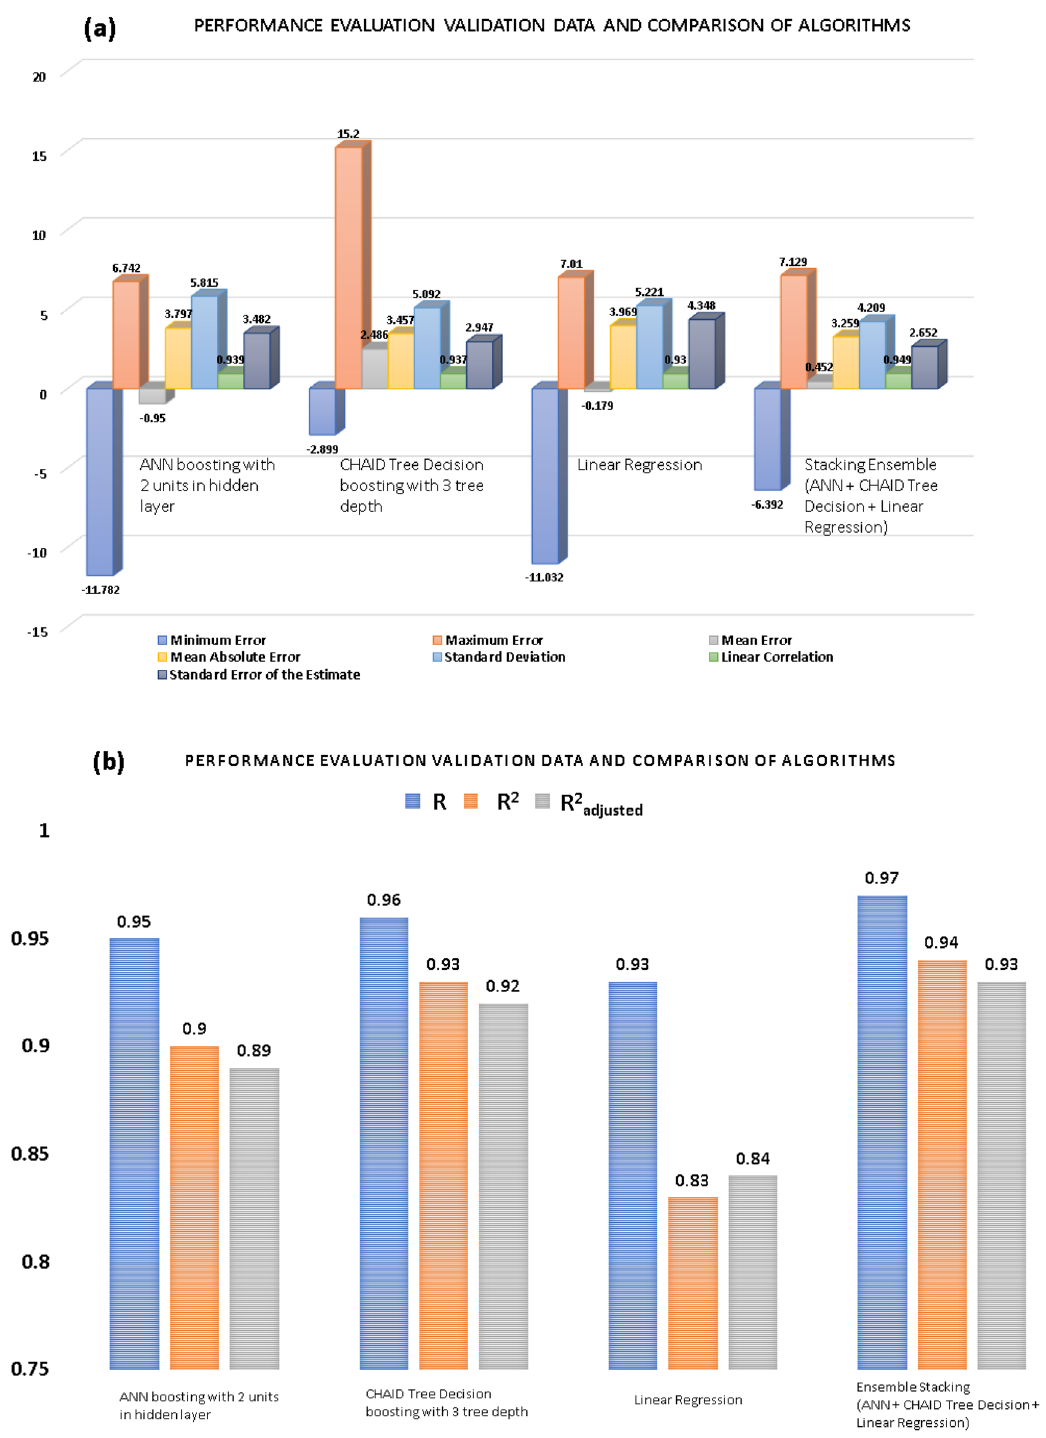
Figure 14. Performance evaluation and comparison ( a ) validation data ( b ) model of